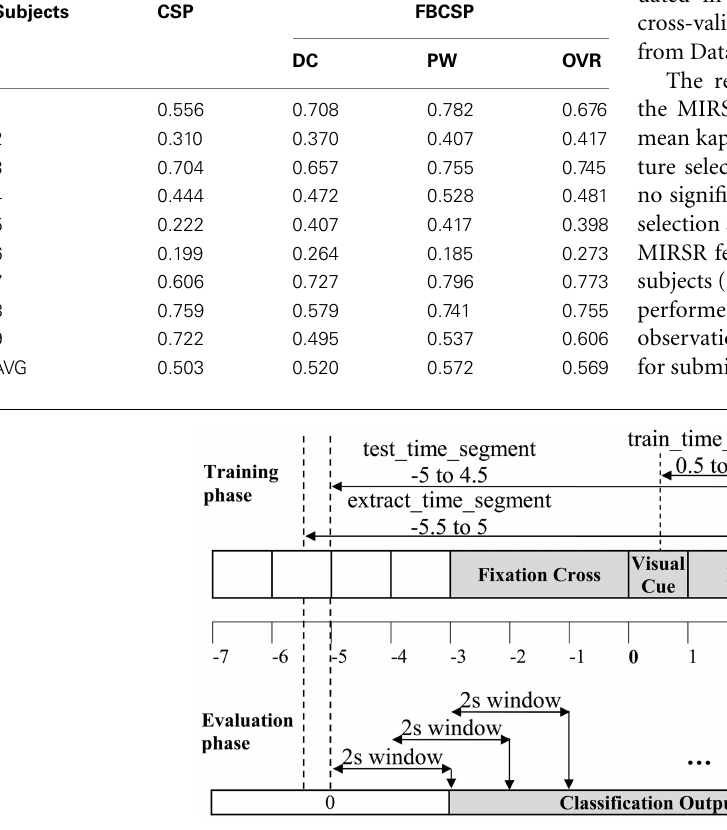
2b, and the generation of the classification outputs using FBCSP on the entire time segment of a single-trial for the evaluation